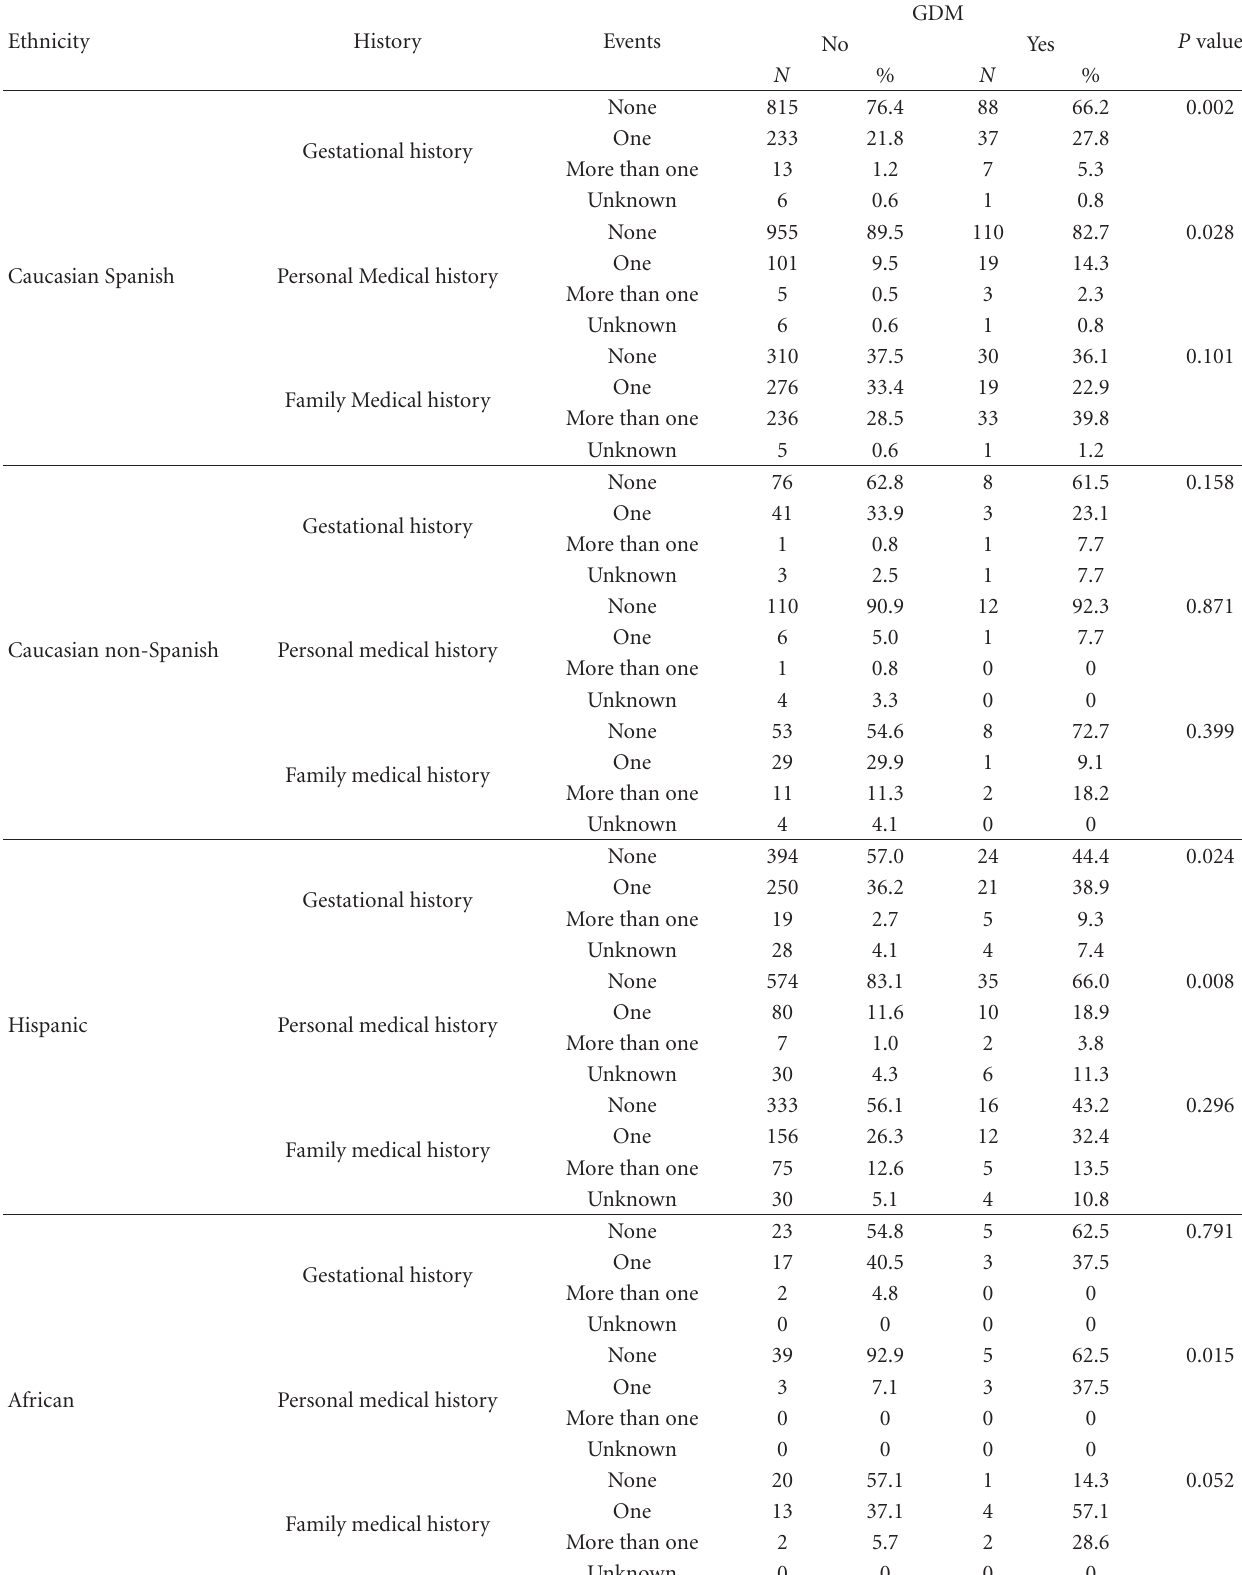
Table 2: Number of women with gestational, personal and family medical history for the 2194 women enrolled in the study, according to the diagnosis of